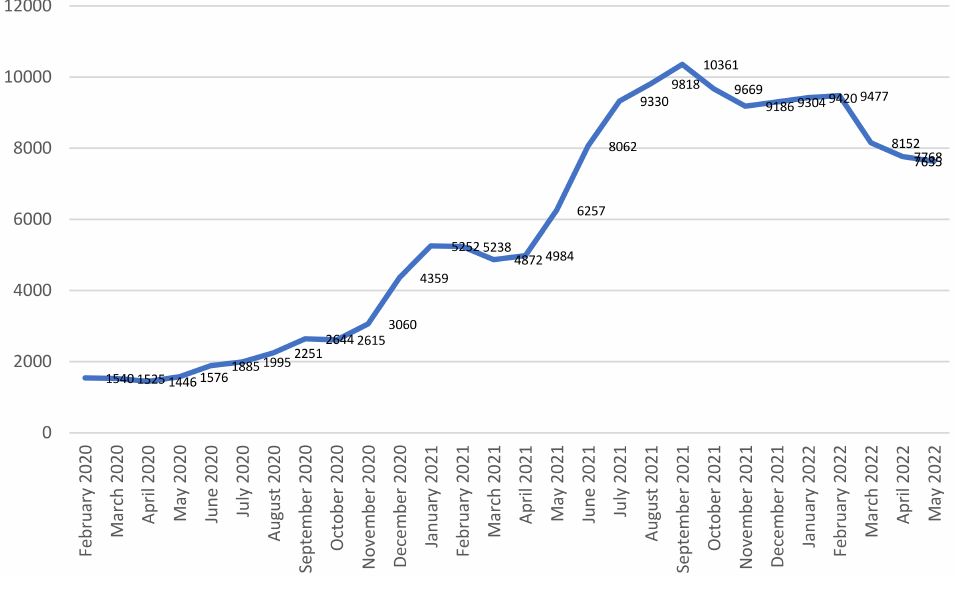
Figure 3. Global maritime container freight rate index, 29 February 2020–31 May 2022. Source: